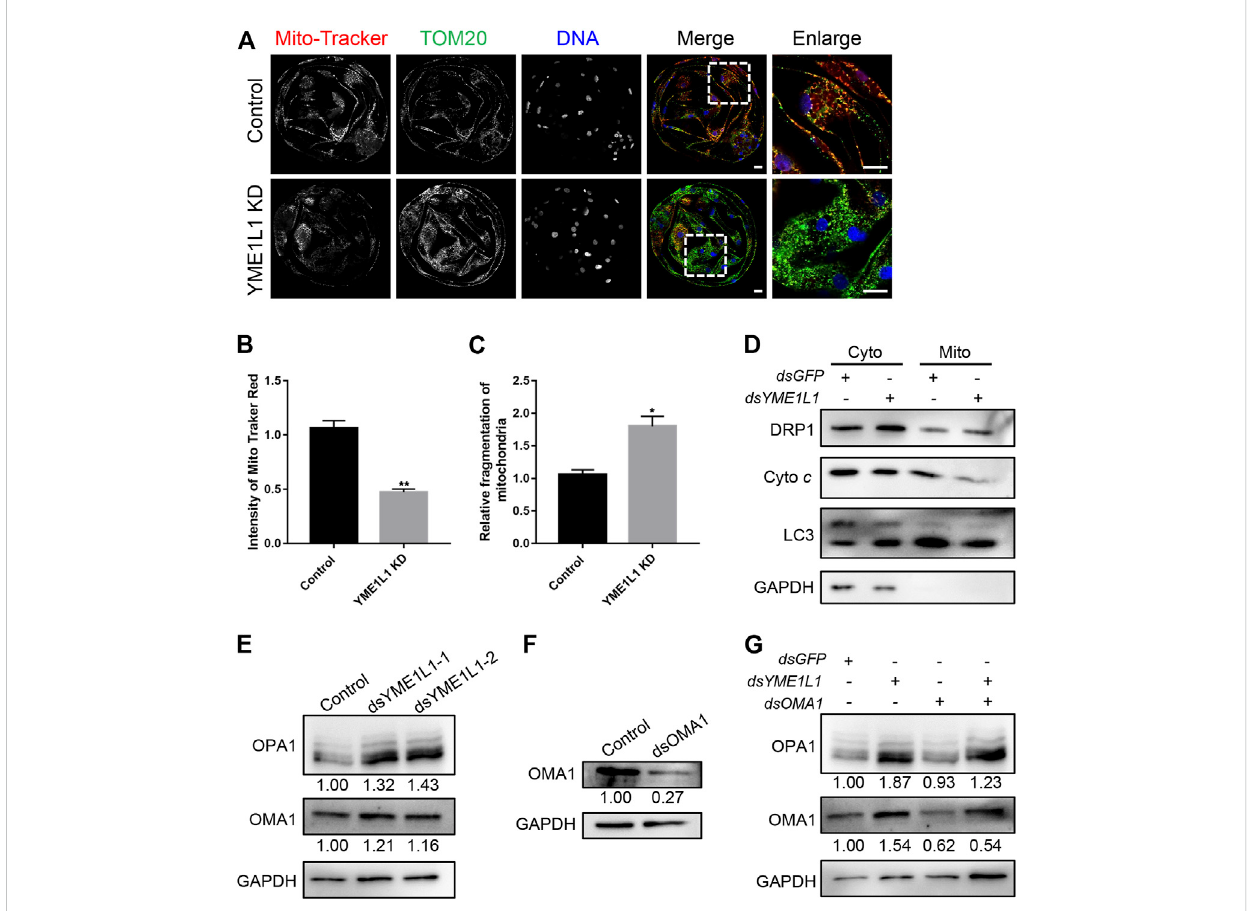
FIGURE 3 Knock-down of YME1L1 induces mitochondrial fragmentation and mitochondrial fi ssion in embryos. (A) Representative immuno fl uorescence images for the mito-tracker and TOM20 in the Control and YME1L1 KD blastocysts. (B, C) Quanti fi cation of immuno fl uorescence images of Control ( n = 10) and YME1L1 KD ( n = 10)blastocyst stage embryos showing the mitochondria intensity and relative mitochondrial fragmentationrate, respectively. (D) Western blotting of blastocysts after isolation of cytosol and mitochondria fraction was performed to detect the level of DRP1, cytochrome c and LC3 in Control and YME1L1 KD group. (E) Protein levels of OPA1 and OMA1 after YME1L1 knock-down at the blastocyst stage by western blot analysis. (F) Protein levels of OMA1 after OMA1 knock-down at the blastocyst stage by western blot analysis. (G) Western blotting of the OPA1 and OMA1 level